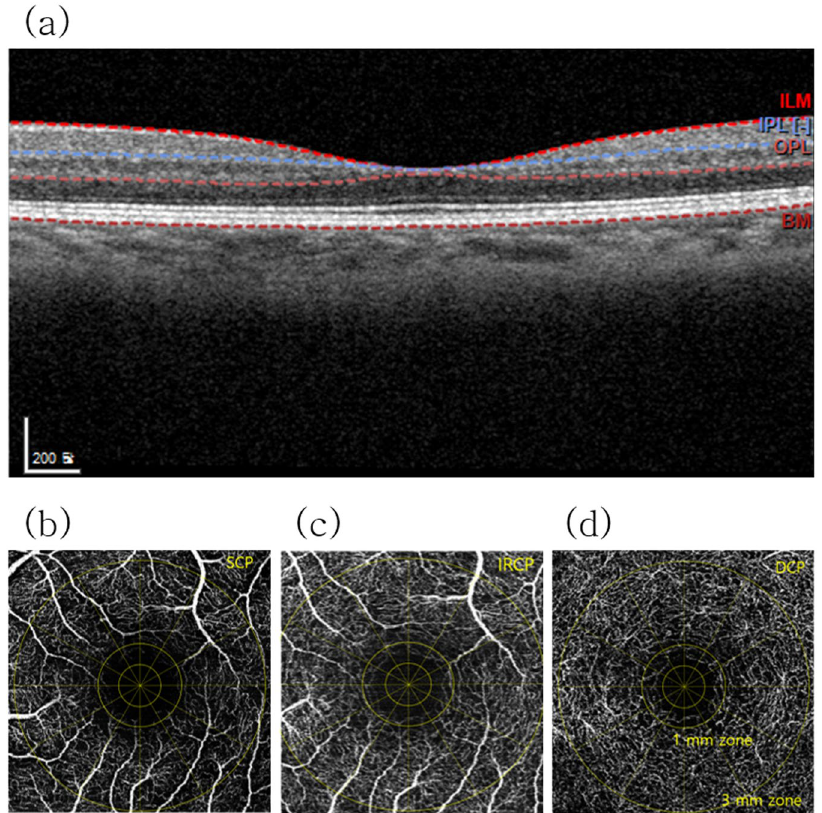
Figure 3. ( a ) OCT image and ( b – d ) OCTA images of the fellow eye in a 69-year-old male patient from the nonrecurrence group. OCTA image of ( d ) the DCP showing a more prominent FAZ than in ( b ) the SCP. Single- layered capillaries are shown to be adherent to the FAZ within ( c ) the inner retinal capillary plexus layer (IRCP) and ( d ) the DCP but not ( b ) the SCP.